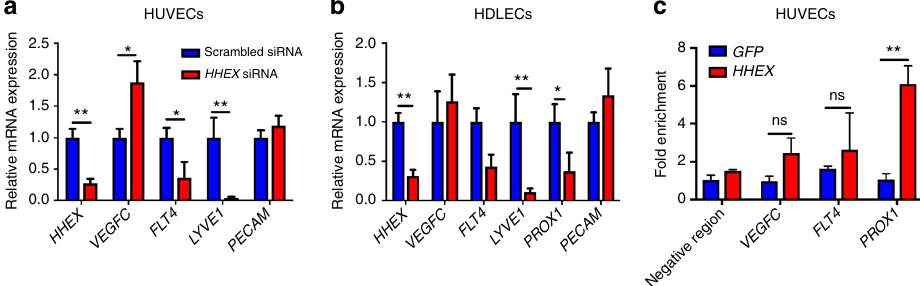
Fig. 10 HHEX regulates the VEGFC/FLT4/PROX1 pathway in human endothelial cells and binds the PROX1 promoter. a , b qPCR analysis of HHEX , VEGFC , FLT4 , LYVE1 , PROX1 , and PECAM expression in HUVECs ( a ) and HDLECs ( b ) treated with HHEX siRNA compared to control cells treated with a scrambled siRNA. Knockdown of HHEX led to downregulation of FLT4 , PROX1 , and LYVE1 and upregulation of VEGFC expression. c Chromatin immunoprecipitation (ChIP) experiment using Myc-HHEX adenovirus in HUVECs. qPCR using primers for speci fi c FLT4 , VEGFC , and PROX1 regions was carried out and enrichment relative to the percentage of input in the IP sample at PRM2 (control region) is shown. HHEX does not appear to bind the FLT4 promoter or VEGFC 3 ′ region but strongly binds the PROX1 promoter. Values represent means ± s.e.m. ** P ≤ 0.01; * P ≤ 0.05; ns, not signi fi cant by Mann-Whitney ( a , b ) or Bonferroni post hoc ( c